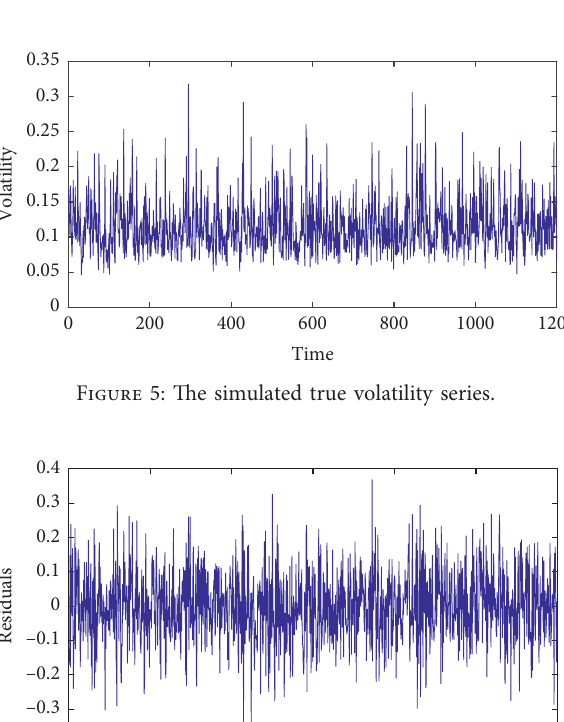
Figure 4: The simulated return series.